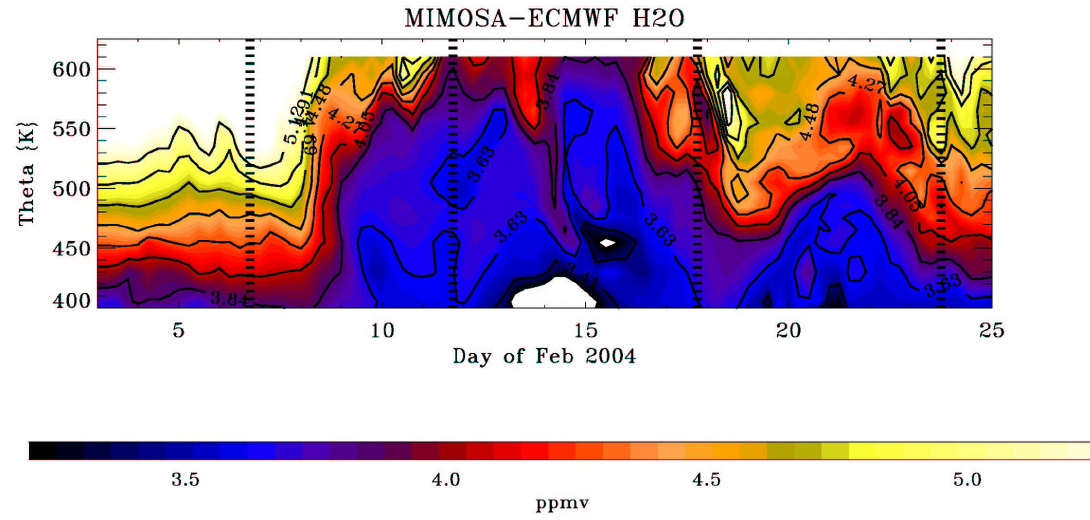
Fig. 5. Water Vapour from ECMWF analyses advected with MIMOSA, for the time period 1 to 25 February 2004 above Sodankyl¨a. The dotted lines indicate the date of the profiles shown in Fig. 4. Figure 5. Water Vapour from ECMWF analyses advected with MIMOSA, for the time period 01 to 25 February 2004 above Sodankylä. The dotted lines indicate the date of the profiles shown in Figure 4.